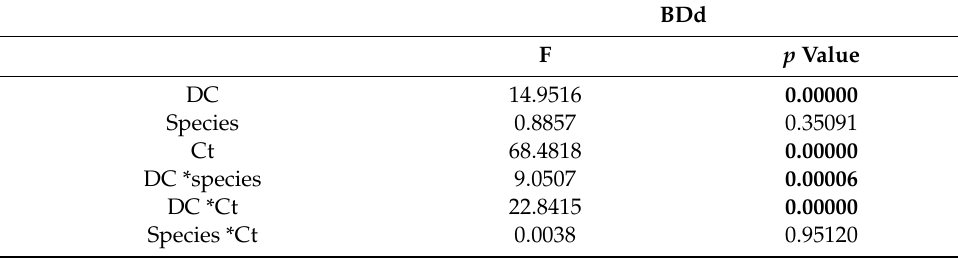
Table 7. Summary of general linear model (GLM) analysis of the e ff ect decay class (DC), species